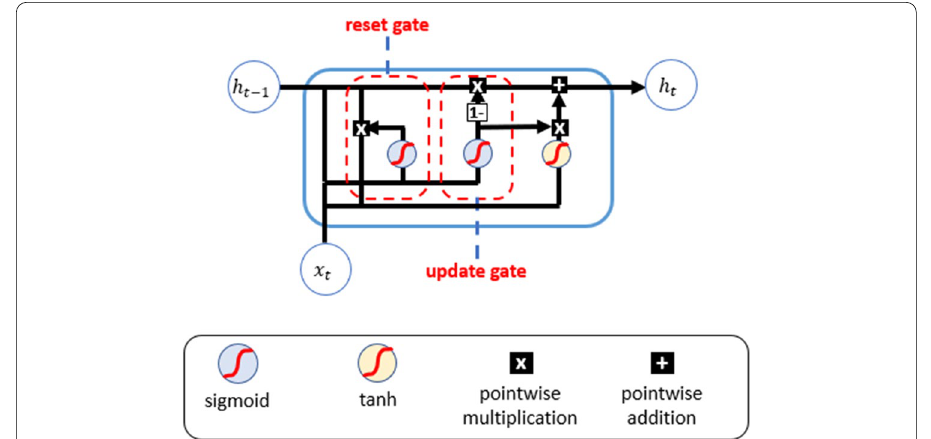
Fig. 4 GRU cell and its gates mechanism